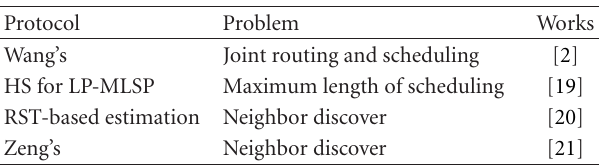
Table 4: Networking with MPR.